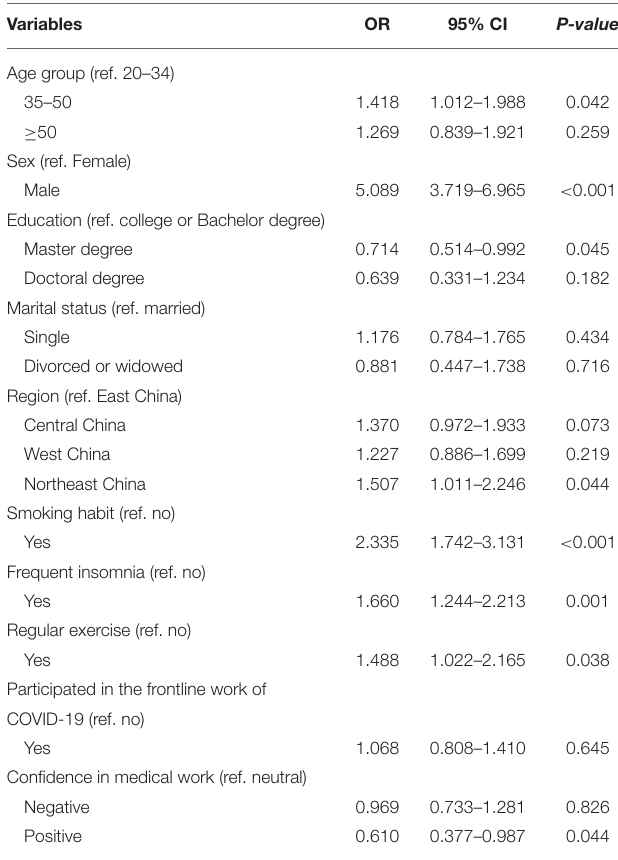
TABLE 2 | Multiple logistic regression examining individual characteristics associated with alcohol misuse in psychiatrists in